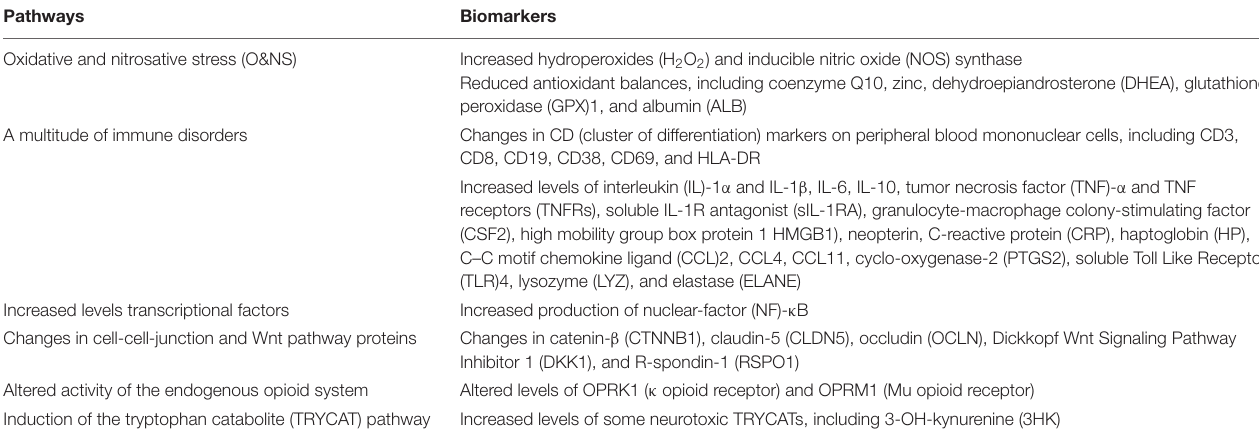
TABLE 1 | The key adverse outcome pathways (AOPs) of the chronic fatigue spectrum disorders (CFAS-Ds), including those that are secondary to medical disorders such as coronavirus disease 2019 (COVID-19), chronic kidney disease, rheumatoid arthritis, schizophrenia, and major depression.